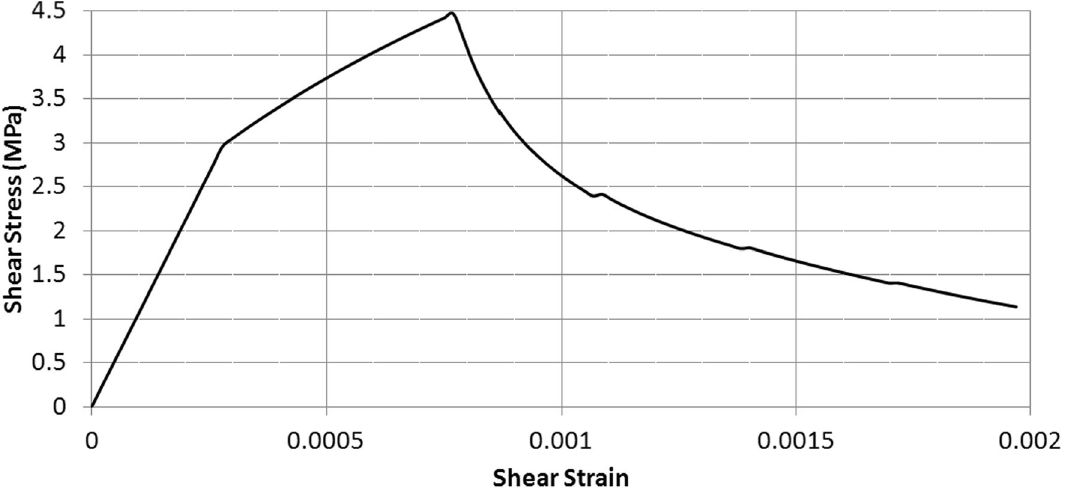
Fig. 10 Simple shear results of CSCM.